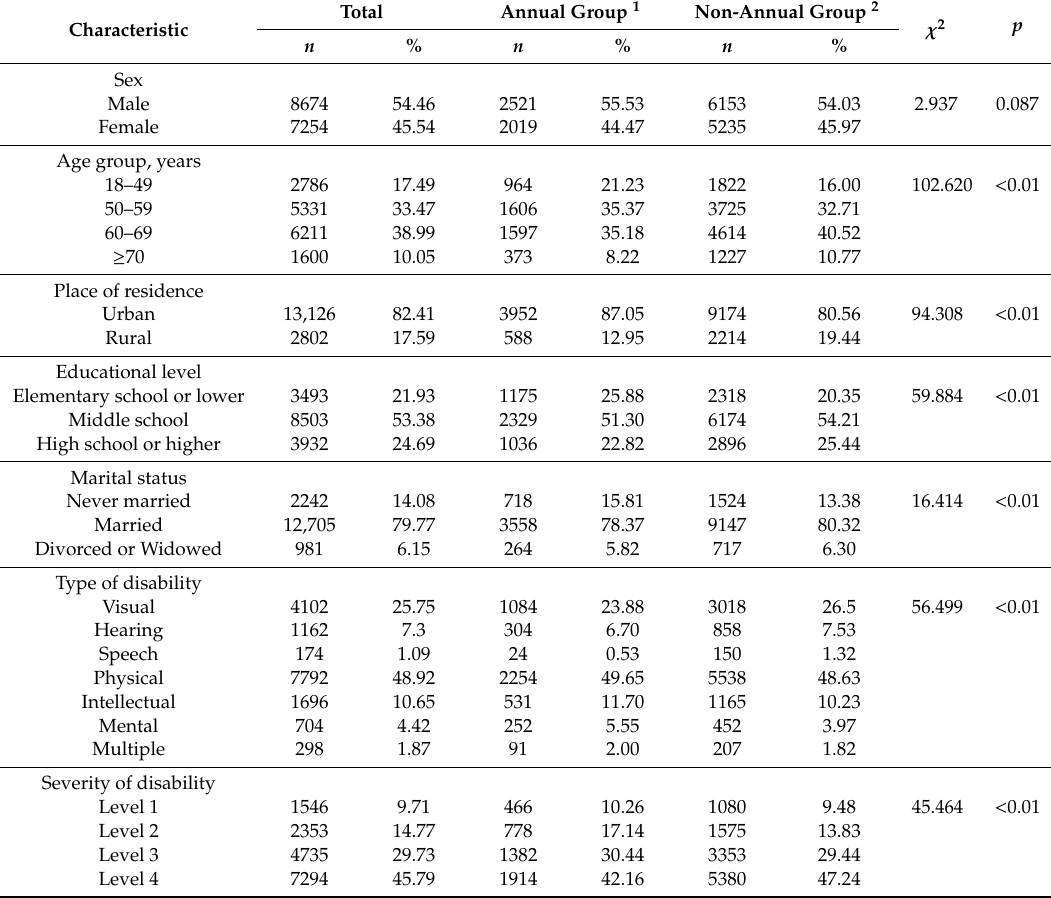
Table 1. Sociodemographic and disability characteristics of the participants by physical examination group.